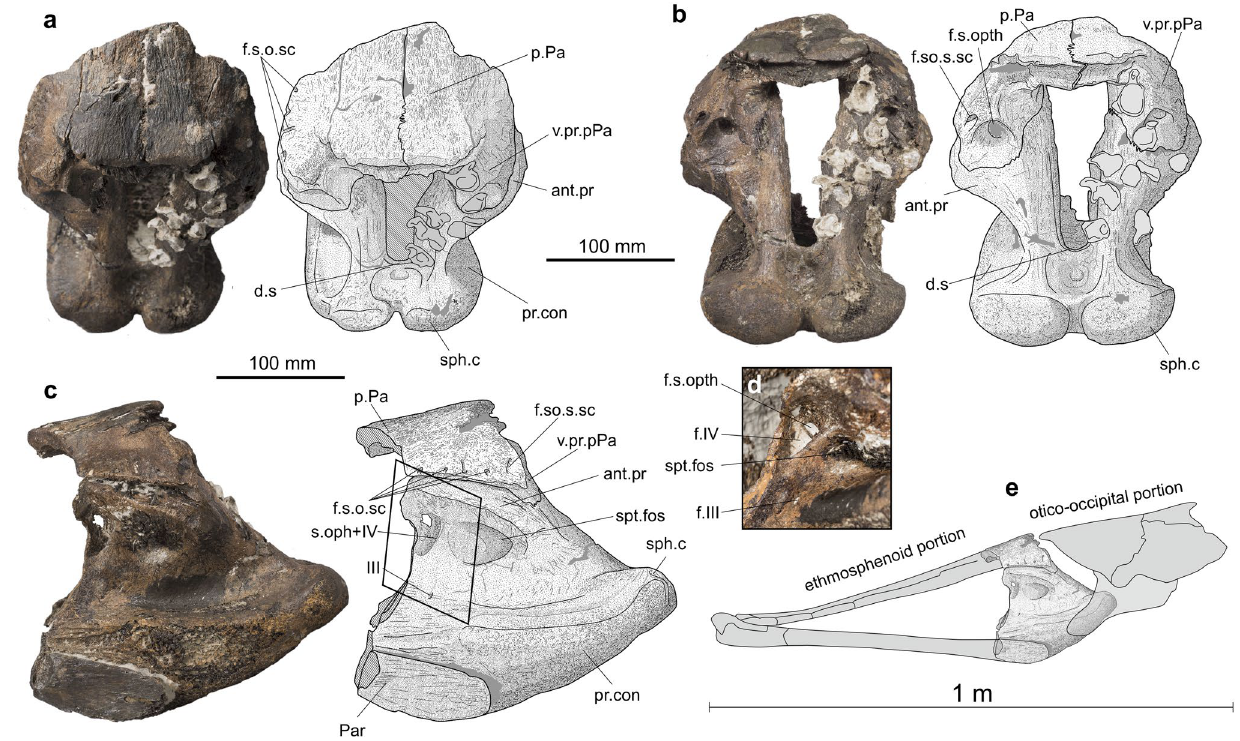
Figure 2. MHNG GEPI V5778. Trachymetopon sp. Basisphenoid with fragments of the posterior parietals and parasphenoid. Dorsal ( a ), dorsoposterior ( b ) and left lateral views ( c ). d , detail of exits of the nerve in anterolaterodorsal view (corresponding approximately to the frame in c ); e , position of the fossil in a schematic reconstruction of the braincase of a mawsoniid coelacanth (modified from Maisey, 1986). Abbreviations: d.s, dorsum sellae; f.s.o.sc, foramen for the supraorbital sensory canal; f.s.opth, foramen for the superficial ophthalmic nerve; s.oph + IV, opening for the superficial ophthalmic nerve and the trochlear nerve; III, foramen for the oculomotor nerve; f.IV, foramen for the trochlear nerve (IV); ant. pr, antotic process; Par, parasphenoid; pr.con, processus conectens; p.Pa, posterior parietal; sph.c, sphenoid condyle; spt.fos, suprapterygoid fossa; v.pr. pPa, ventral process of the parietal